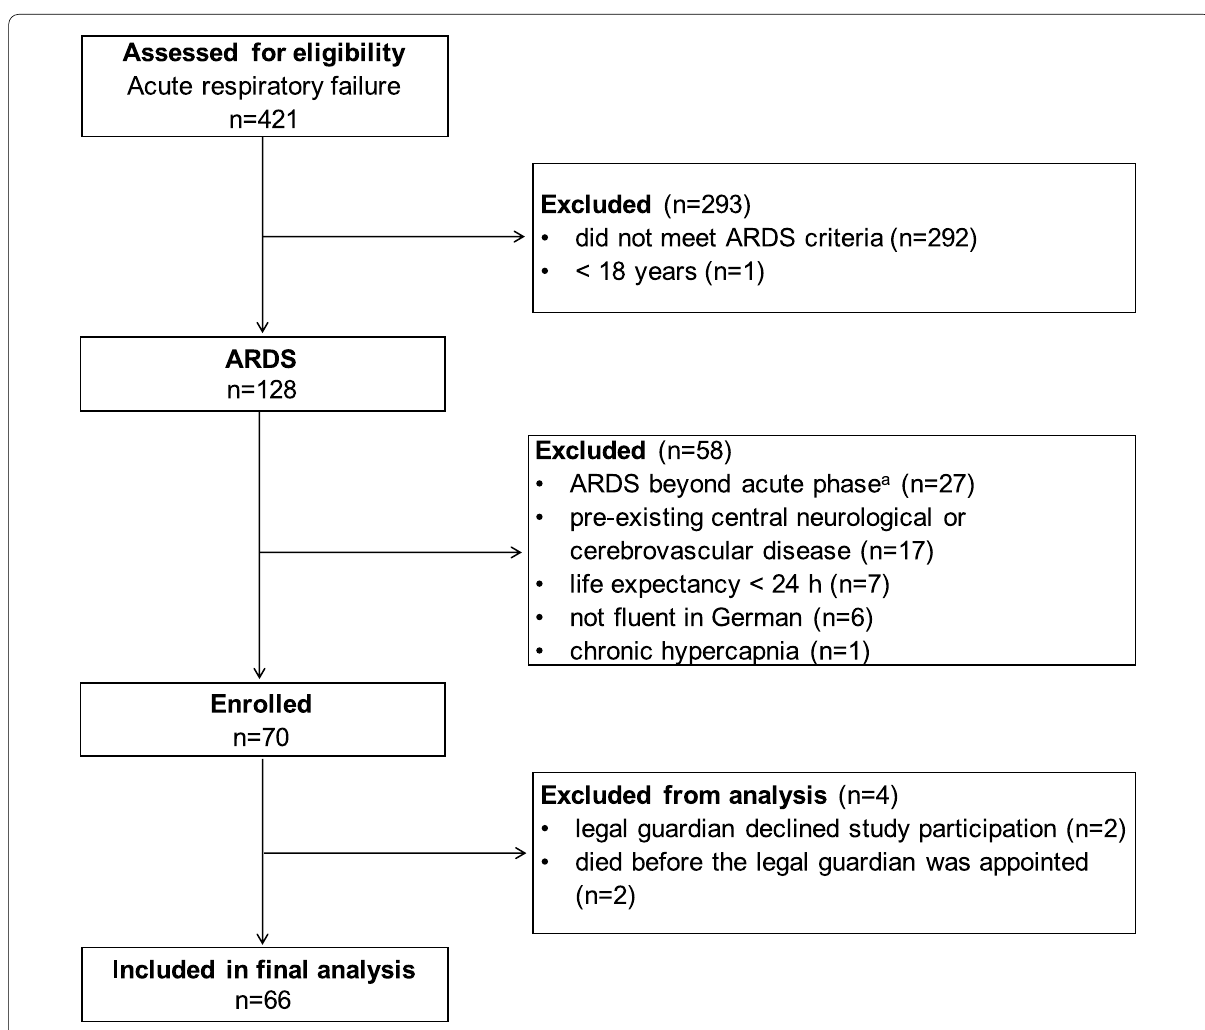
Fig. 1 Flowchart of patient selection and enrolment. a > 6 days from the onset of acute respiratory distress syndrome